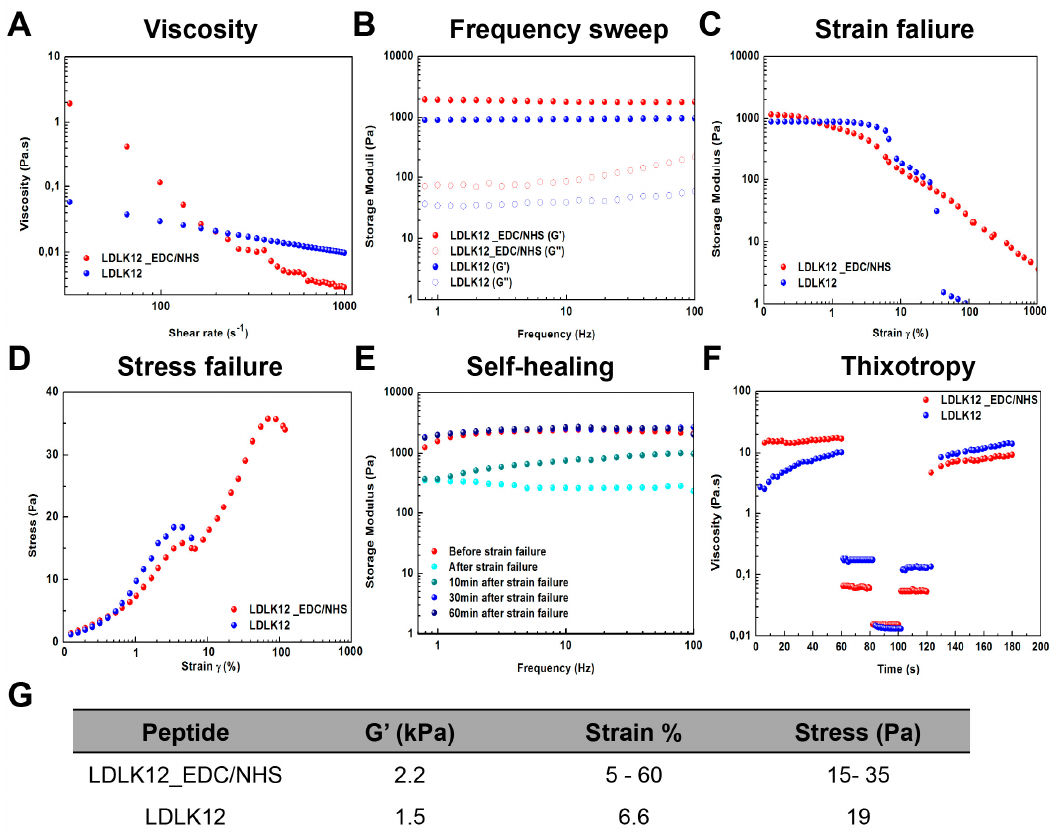
Figure 2. Rheological studies to evaluate the mechanical properties of the LDLK12 hydrogels. ( A ) Viscosity measurements at increasing shear rate of the wildtype and cross-linked LDLK12 peptides; ( B ) frequency-dependent oscillatory rheology (0.1–100 Hz) of the LDLK12 hydrogels (1% w / v ) at 1% strain (within the linear viscoelastic regime (LVR)); ( C ) strain– and ( D ) stress–sweep analyses of LDLK12 hydrogels at a constant frequency of 1 Hz (cross-linked LDLK12 exhibited an unusual two-step shear strain–stress behavior); ( E ) self-healing of cross-linked LDLK12; ( F ) thixotropy test of standard and cross-linked LDLK12 peptide solutions; and ( G ) average values of the storage modulus (G (cid:48) ), strain, and